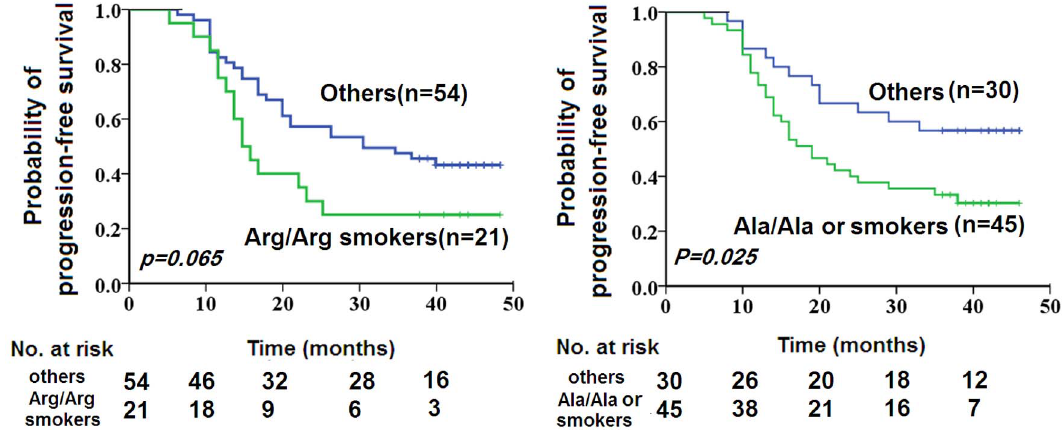
Figure 2. Kaplan-Meier progression-free survival (PFS) curves according to SNPs of DNA repair genes. A represents PFS curves according to the combination of XRCC1 Arg399Gln and smoking status; B shows PFS curves according to ERCC1 Cys8092Ala and smoking status.